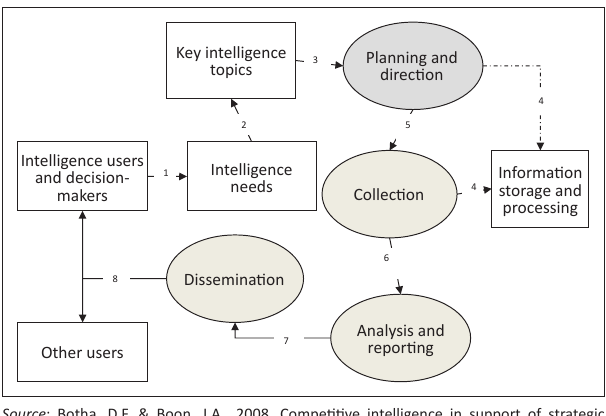
FIGURE 1: The competitive intelligence